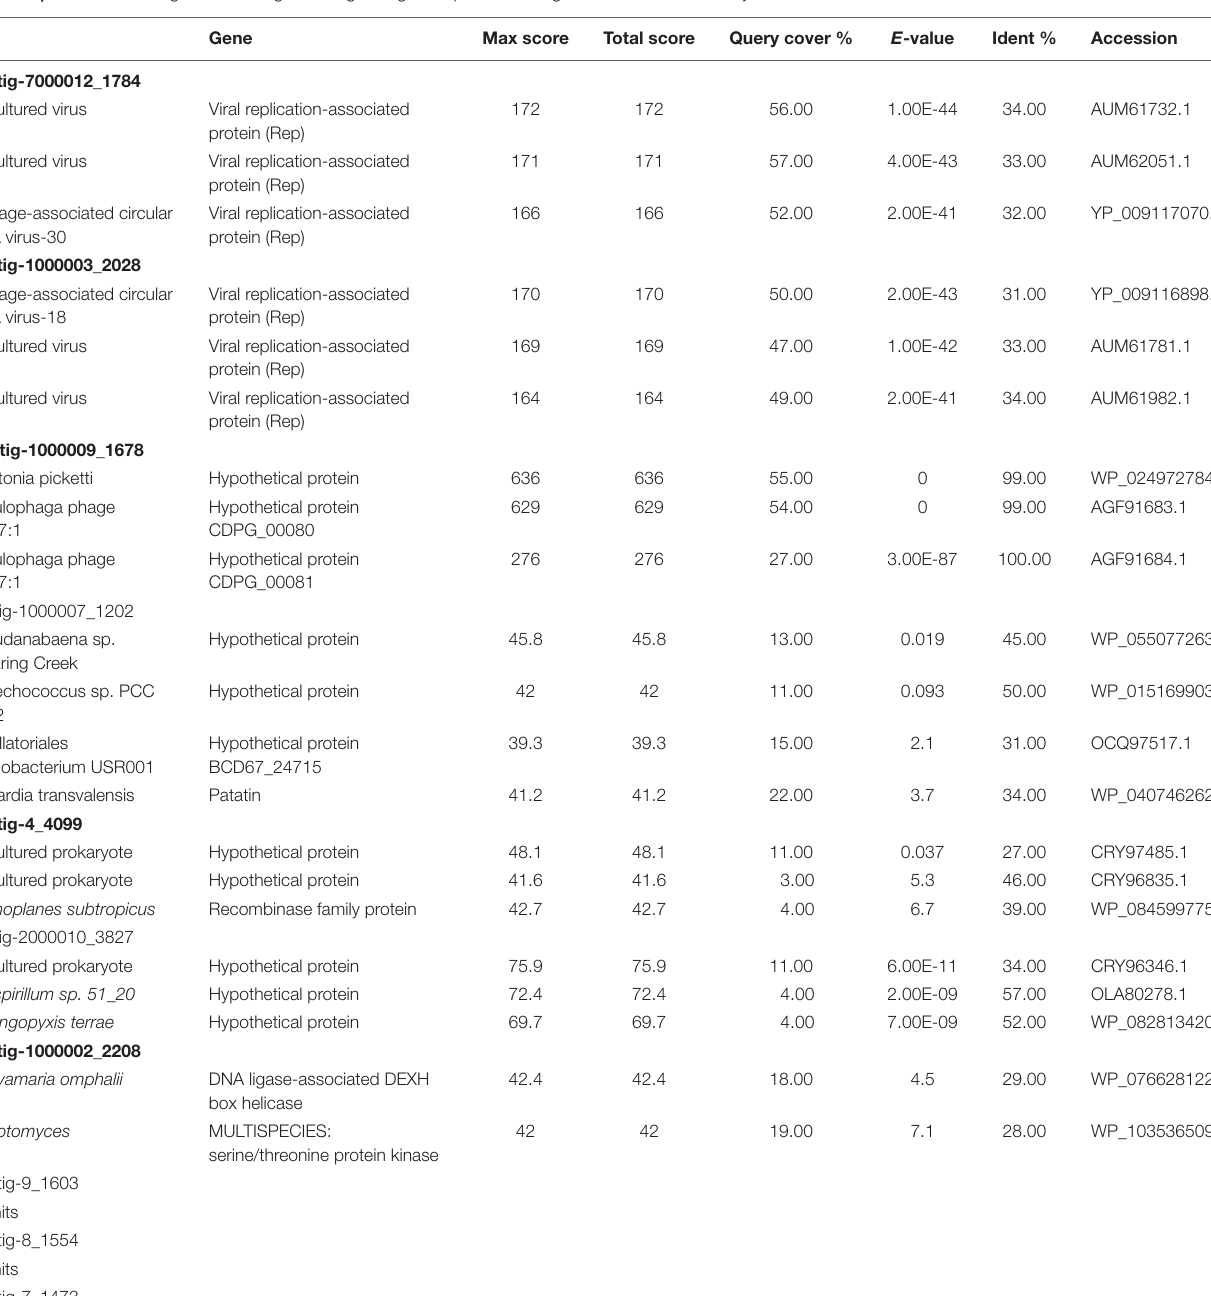
TABLE 3 | BLAST results against NCBI against long contigs and putative viral genomes in the Shark Bay viral fraction. Gene Max score Total score Query cover